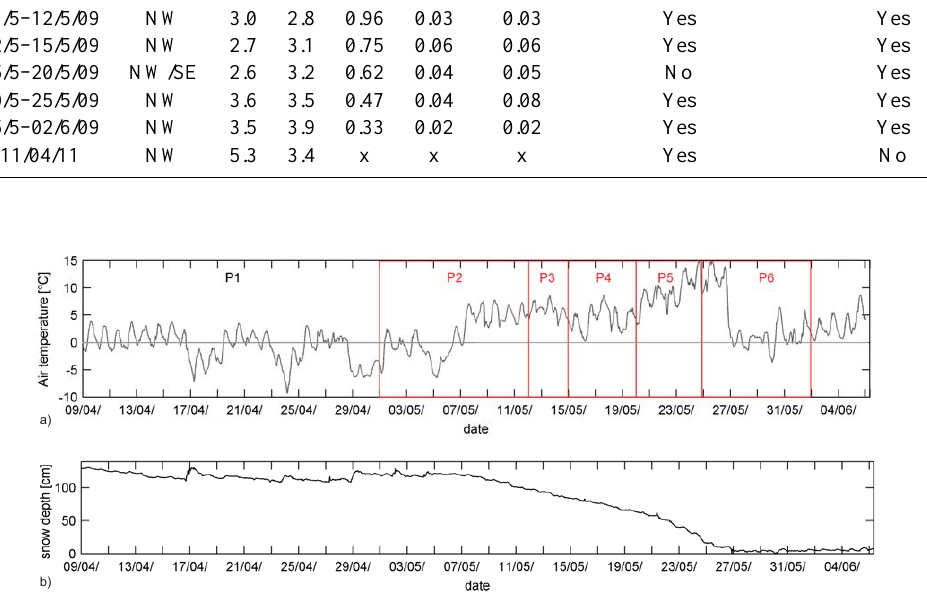
Fig. 2. Hourily time series of air temperature [ ◦ C] (a) and snow depth (b) obtained from weather station WAN3 for ablation season 2009.